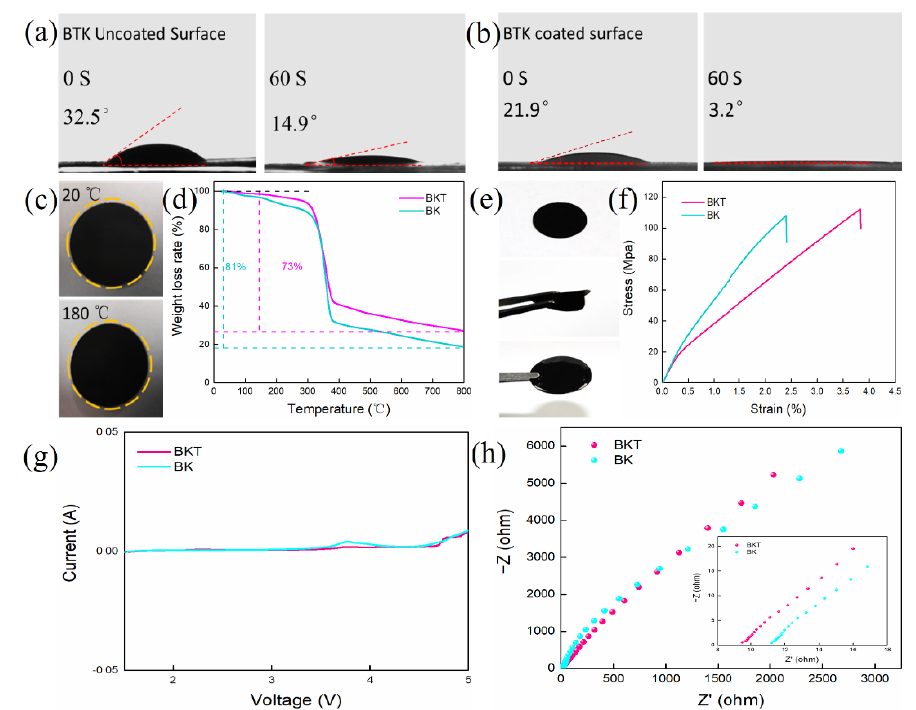
Figure 3. ( a ) Wettability of BKT uncoated surface to electrolyte; ( b ) Wettability of BKT coated surface to electrolyte; ( c ) Thermal dimensional stability of BKT separators at different temperatures; ( d ) TGA diagram of BKT and BK separator; ( e ) Mechanical properties of BKT separators; ( f ) BKT and BK separator Stress Strain Curve; ( g ) Linear sweep voltammetry (LSV) test for assembled (SS/separator/Li) battery.; ( h ) Nyquist diagram of assembled (SS/separator/SS) battery.